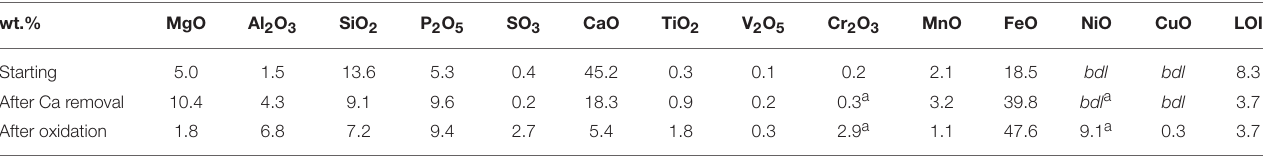
TABLE 1 | Semi-quantitative µ XRF analysis (error ± 20%) of the three steel slag samples, i.e., starting slag, de-calcified slag, and the recovered sample after oxidation of the decalcified slag ( APAc-1M-250C) . wt.%